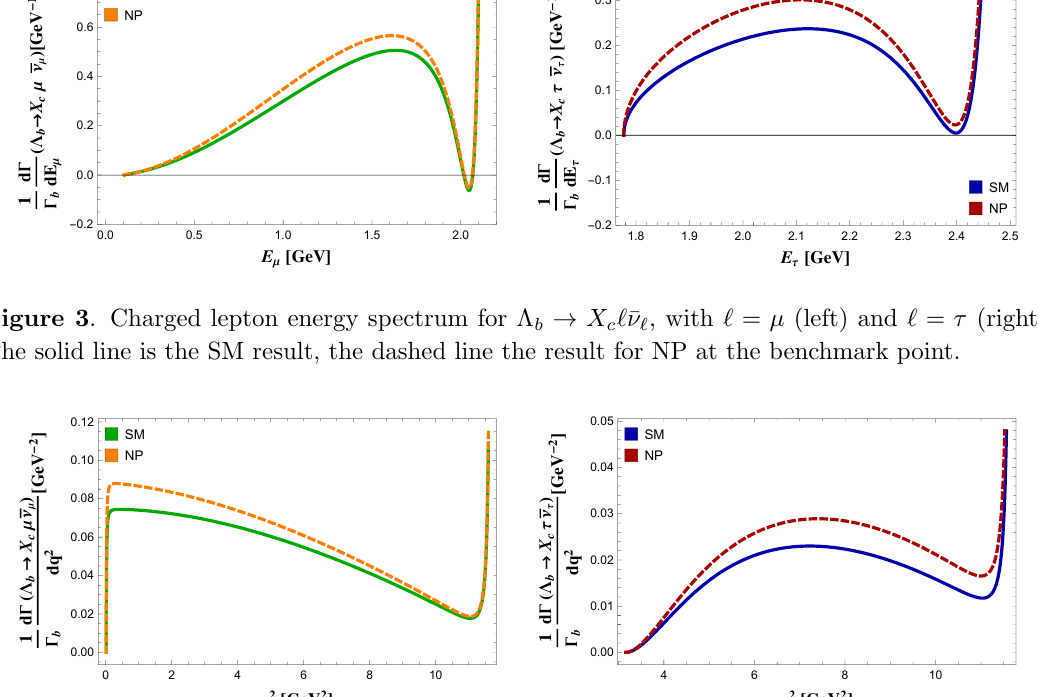
) (red line) and at O (1 =m 3 ) b b